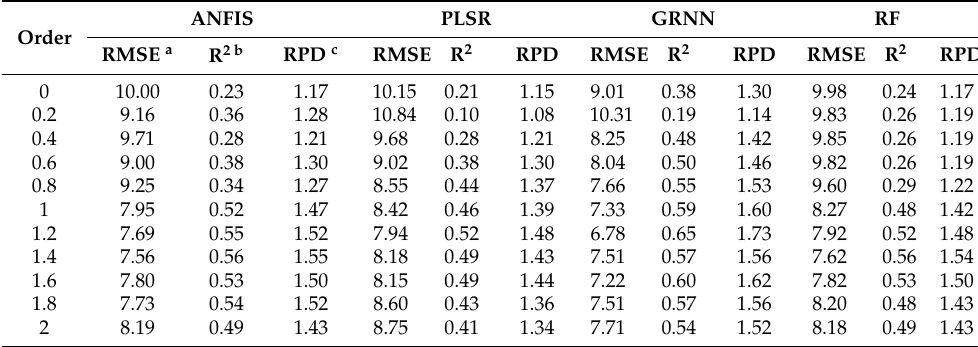
Table 7. Estimation model accuracy of Hg.